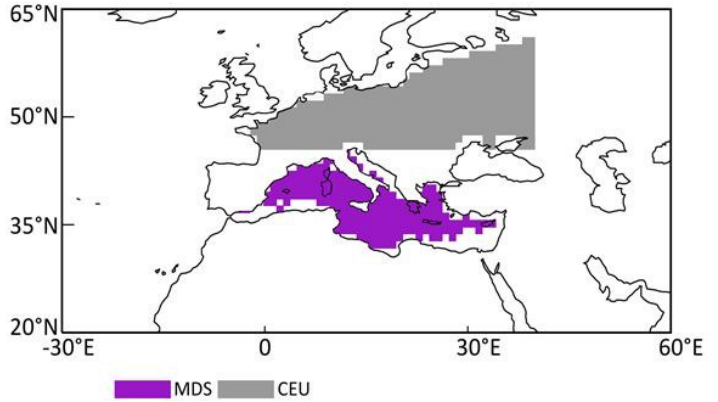
Figure 1. Central and Europe region (CEU, grey) with boundaries defined from the 5th Assessment Report (AR5) of the Intergovernmental Panel on Climate Change (IPCC), with the Mediterranean Sea (MDS, purple color) source identified using a backward-in-time experiment according to Stojanovic et al. [13].